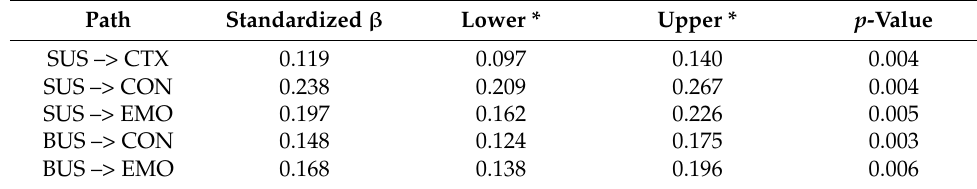
Table 4. Standardized indirect effects.